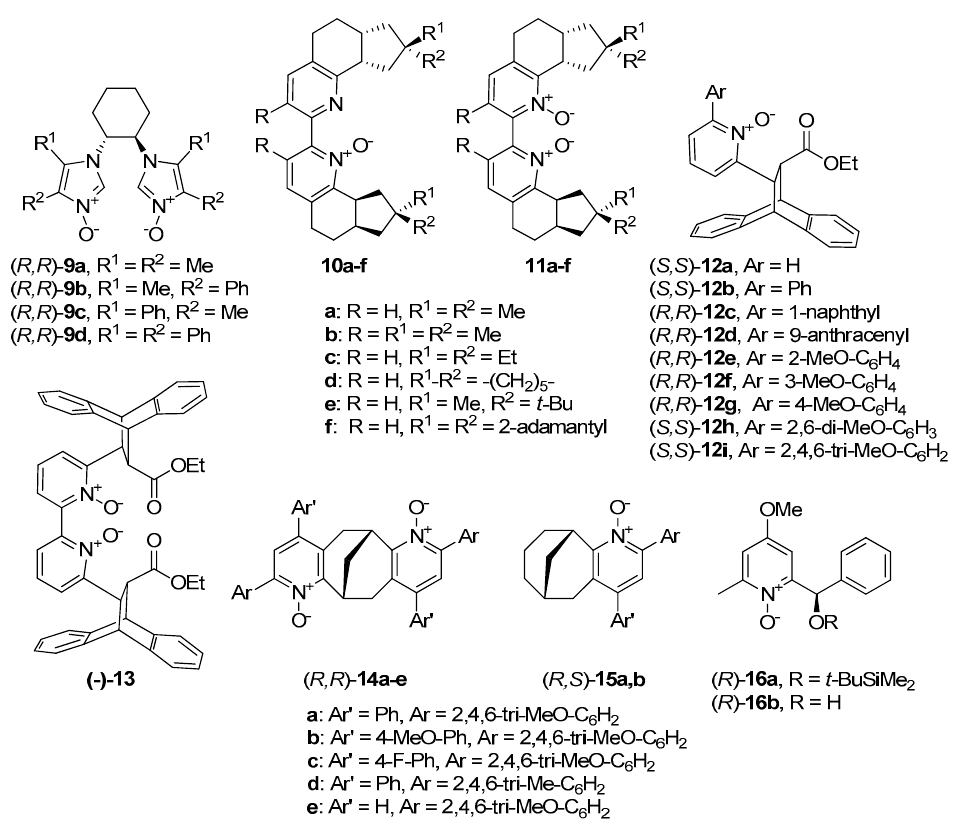
Figure 2. N -oxides possessing a central element of chirality.